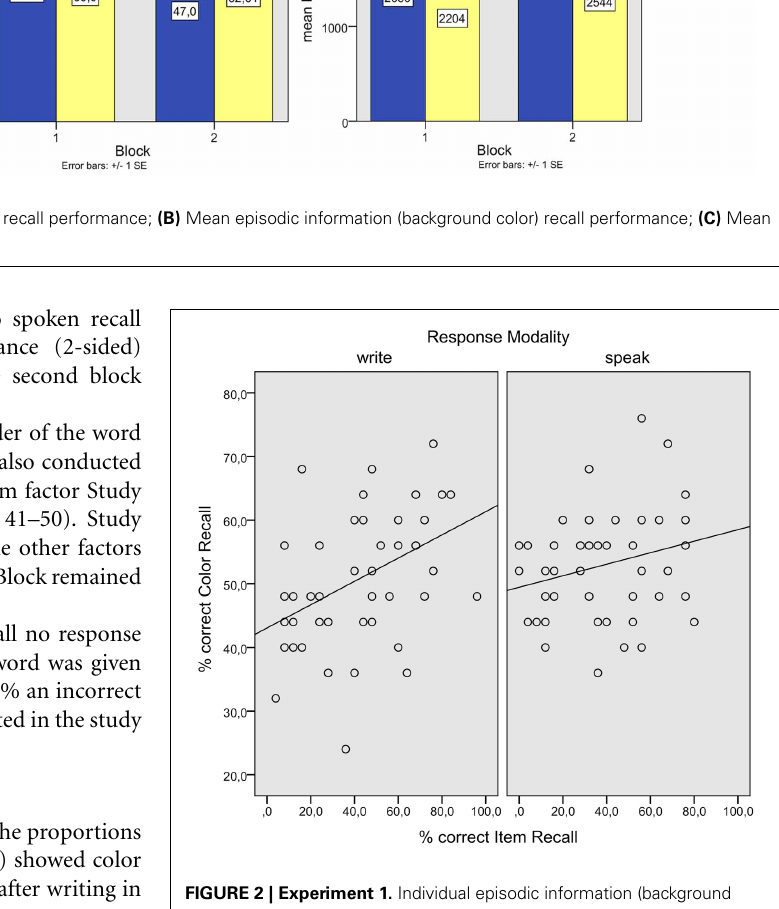
FIGURE 2 | Experiment 1. Individual episodic information (background color) recall performances plotted against associate word (item) recall